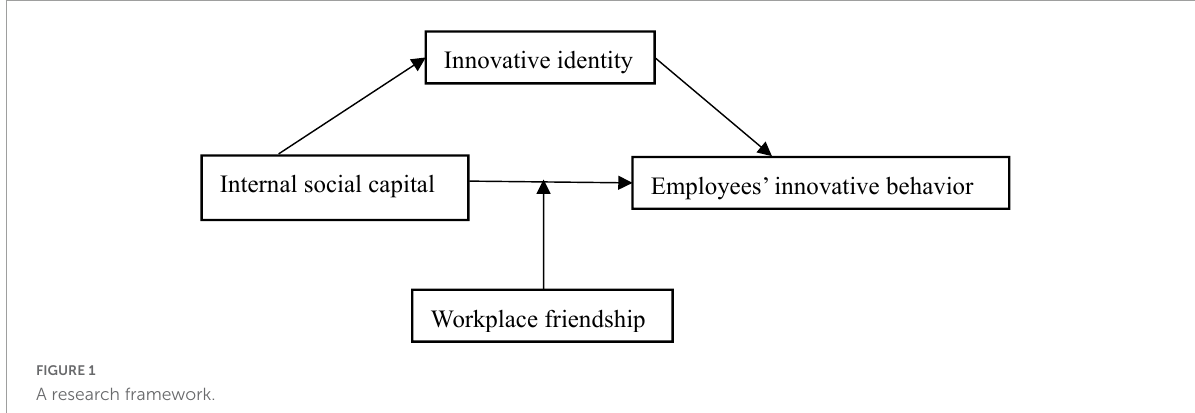
FIGURE1 A research